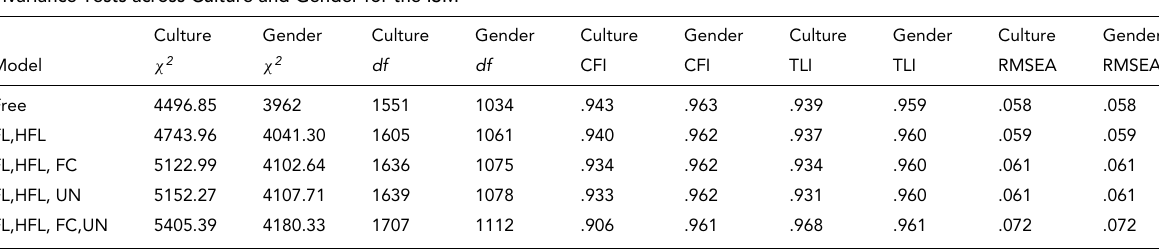
Invariance Tests across Culture and Gender for the